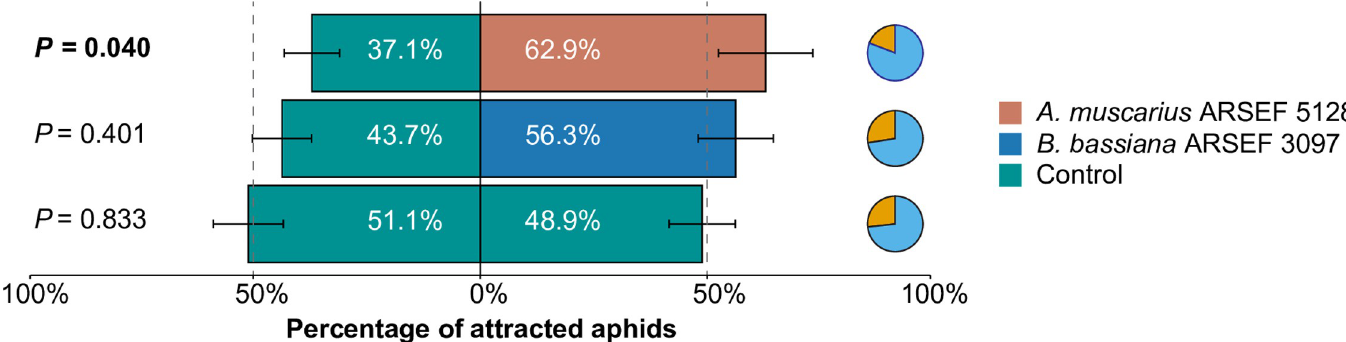
Fig 1. Olfactory response (attraction % ± SEM) of winged Myzus persicae var. nicotianae when given the choice between sweet pepper plants inoculated with Akanthomyces muscarius ARSEF 5128 (orange) or Beauveria bassiana ARSEF 3097 (blue) and control plants (green), in a Y-tube olfactometer bioassay (tested in 24 cohorts of 5 adults). P values in bold indicate significant differences in aphid response ( P � 0.05) when compared to a theoretical 50:50 distribution (Generalized Linear Mixed Model). Dashed lines indicate the 50% threshold. Pie charts show the percentage of responding (blue) and non-responding (orange) aphids. Overall aphid responsiveness was 75.6%.